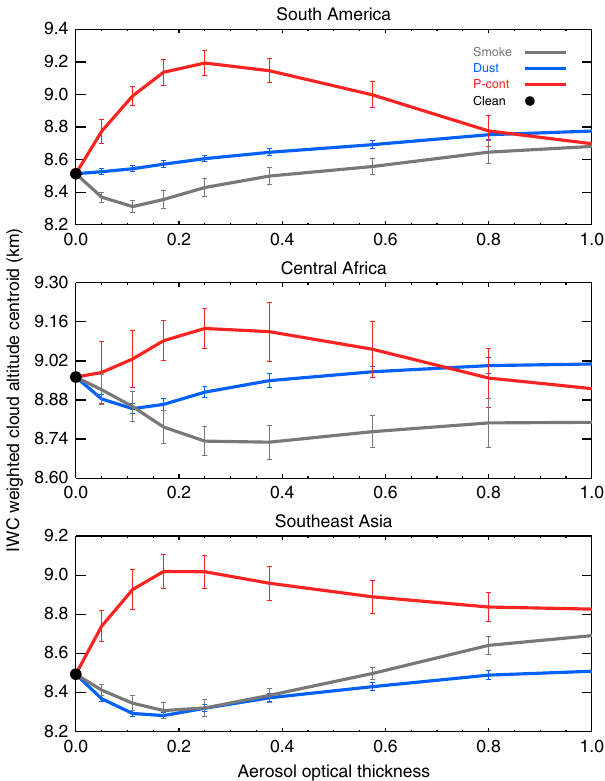
Fig. 3 Non-monotonic responses of convective cloud to aerosol perturbation in different aerosol environments. IWC weighted altitude centroid for smoke aerosol (gray line), dust aerosol (blue line) and polluted continental aerosol (red line) as a function of aerosol optical thickness (AOT) for SAM (top panel), CAF (middle panel) and SEA (lower panel). The AOT includes aerosols above 500 m over the surface, see Methods section for details. The error bars denote the standard errors of the bin